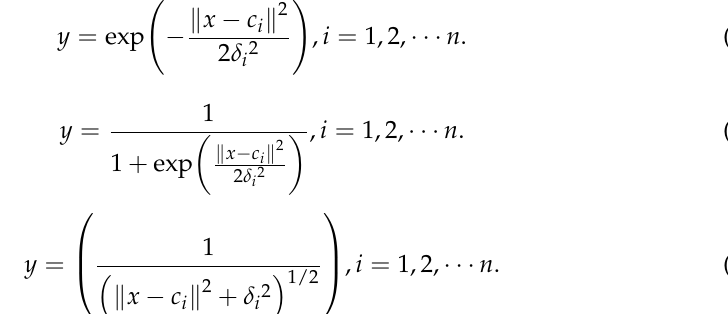
where x is the input vector, n -dimensional, c i is the center vector of the i -th basis function, n -dimensional; ǁ x - c i ǁ is the Euclidean distance between vector x and vector c i ; δ i is the width of the i -th basis function. The Gaussian function, Inverse S-type function and quasi-multi-quadratic function are respectively shown in Figure 9. If the width δ i of the radial basis function is smaller, the basis function is more selective.